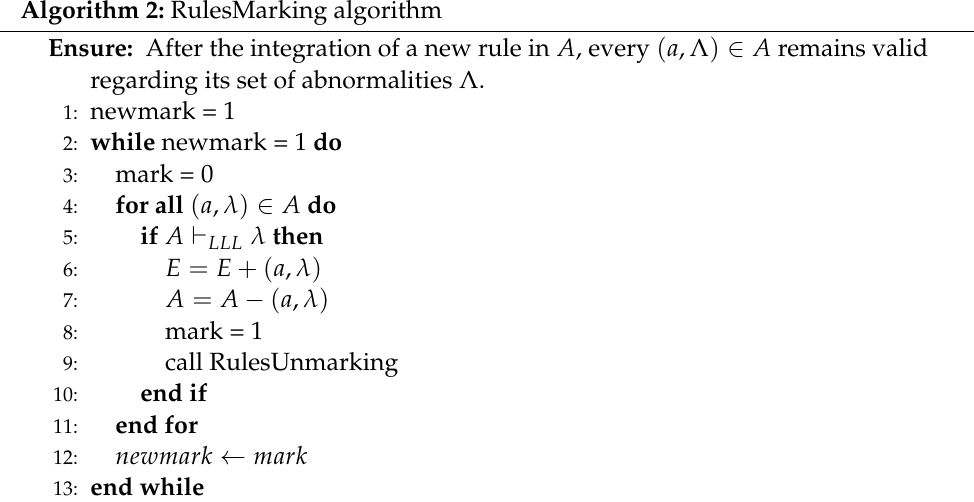
Algorithm 2: RulesMarking